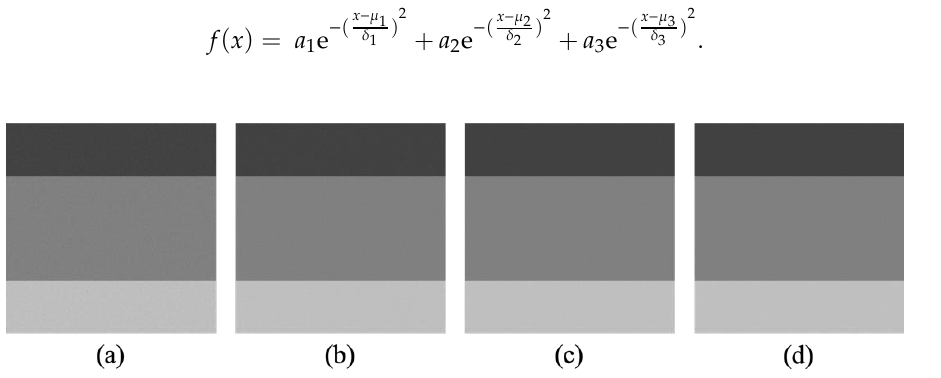
Figure 2. Reconstructed images after ( a ) 50; ( b ) 100; ( c ) 150; and ( d ) 200 Gerchberg – Saxton (GS) iterations.